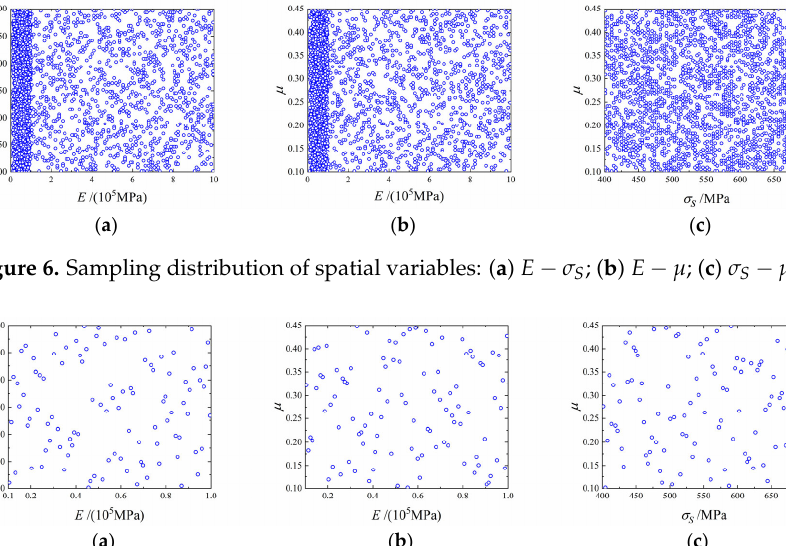
− µ ; ( c ) σ − µ S ; ( b ) E S